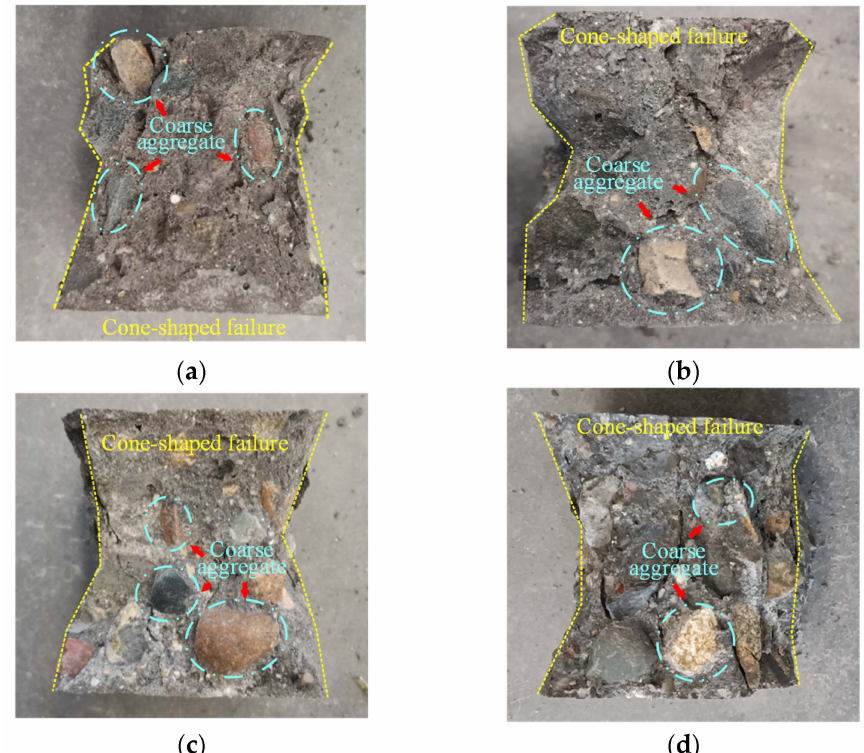
Figure 7. Failure performance of NF specimens with different ages after cube compressive test: ( a ) 3 d; ( b ) 7 d; ( c ) 14 d; and ( d ) 28 d.